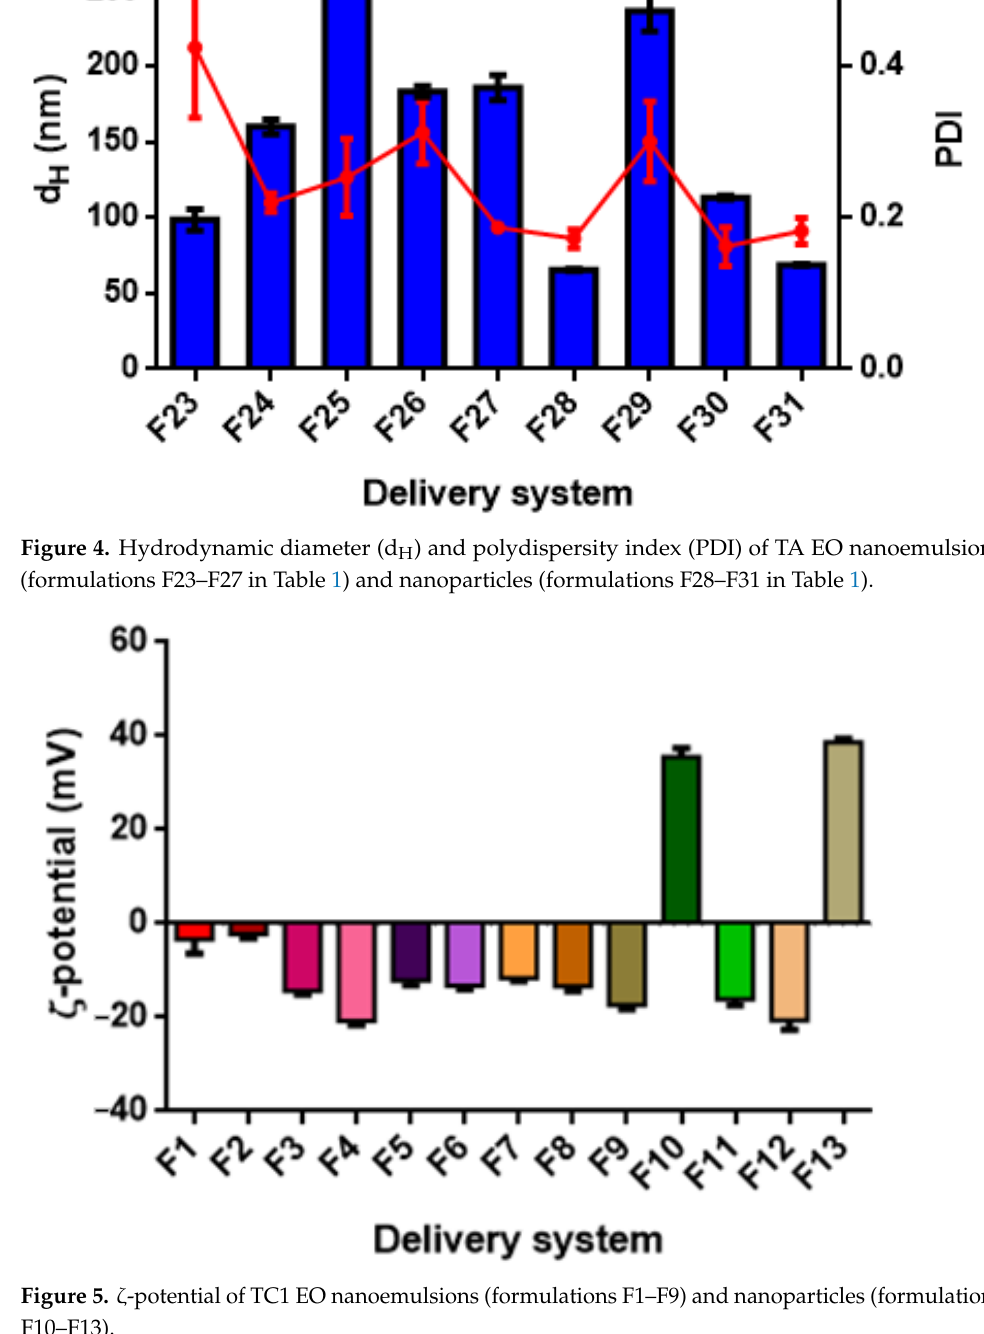
Figure 5. ζ -potential of TC1 EO nanoemulsions (formulations F1–F9) and nanoparticles (formula- tions F10–F13).